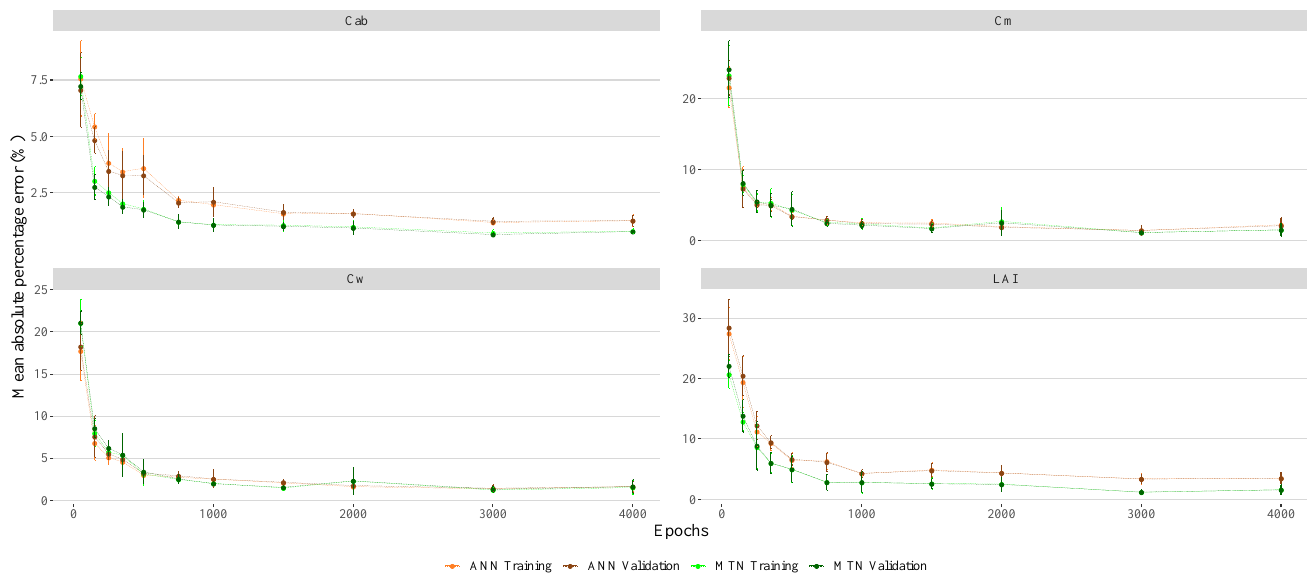
Figure A1. Neural networks training and validation error in function of epochs. Error bars represent the standard deviation of a 5-fold cross-validation procedure.